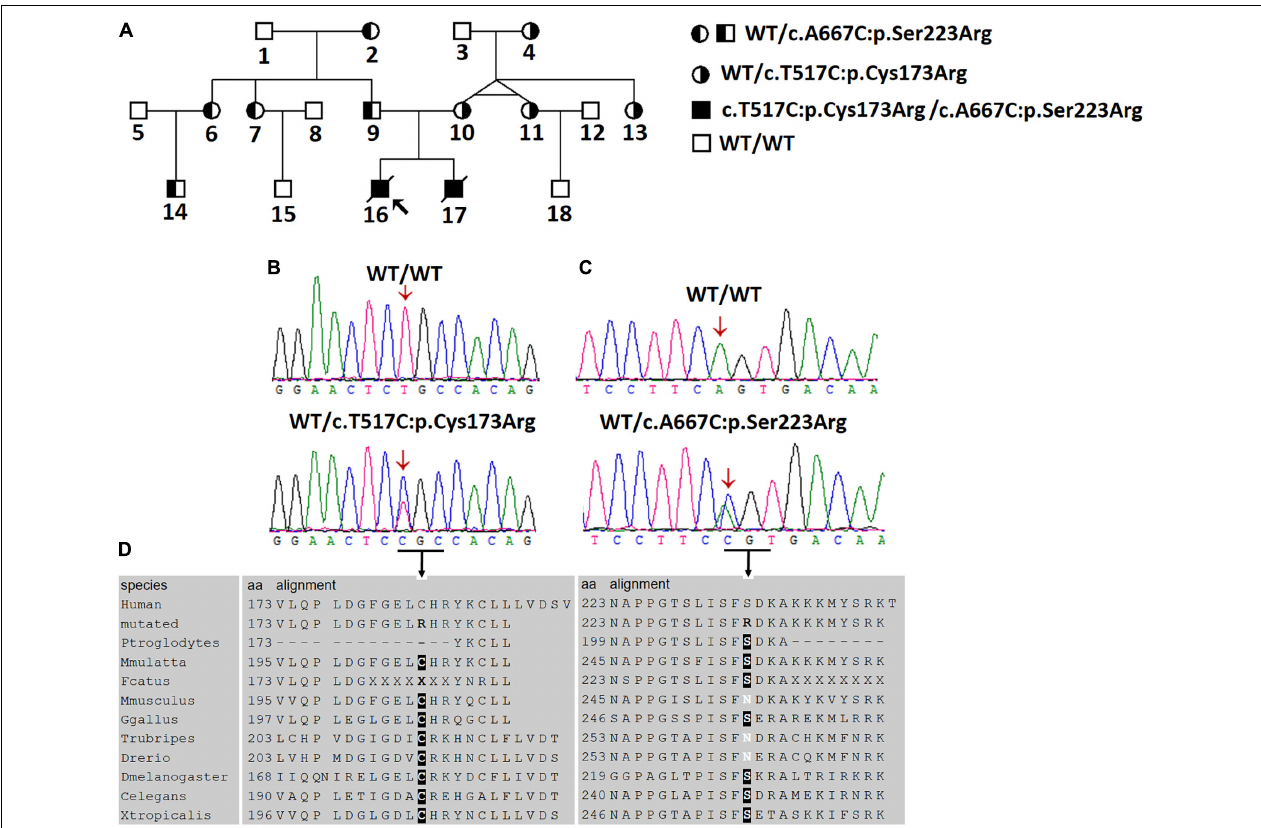
FIGURE 1 | Two novel AGXT mutations in a Chinese family with the infantile form of primary hyperoxaluria type I (PH1). (A) Investigated Chinese family with PH1. Subjects 16 and 17 suffered from the infantile form PH1. Subjects 4, 10, 11, and 13 were affected by benign urolithiasis at least once, and other family members were asymptomatic. (B,C) Sanger sequencing revealed the AGXT gene mutations, c.517T > C/p.Cys173Arg and c.667A > C/p.Ser223Arg. (D) Both mutations occurred on the conserved residues of the AGT